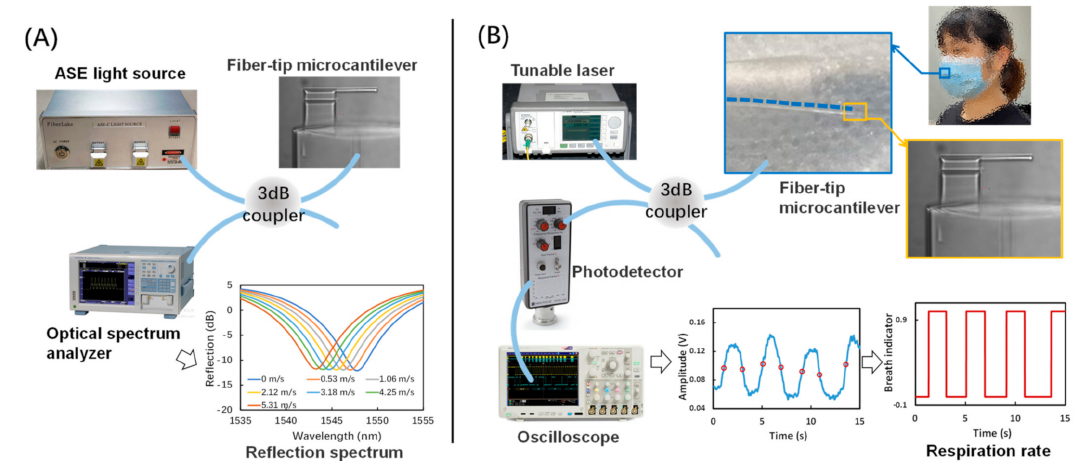
Figure 3. The experimental setups for ( A ) reflection spectrum measurement and ( B ) breath